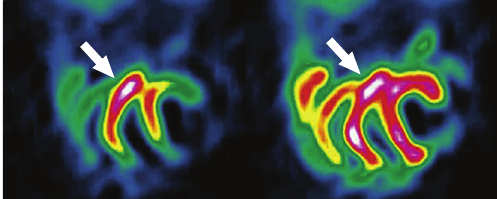
Figure 6: The same patient, abdomen SPECT, coronal slices. Mas- sive leukocyte uptake in the whole small intestine—m.